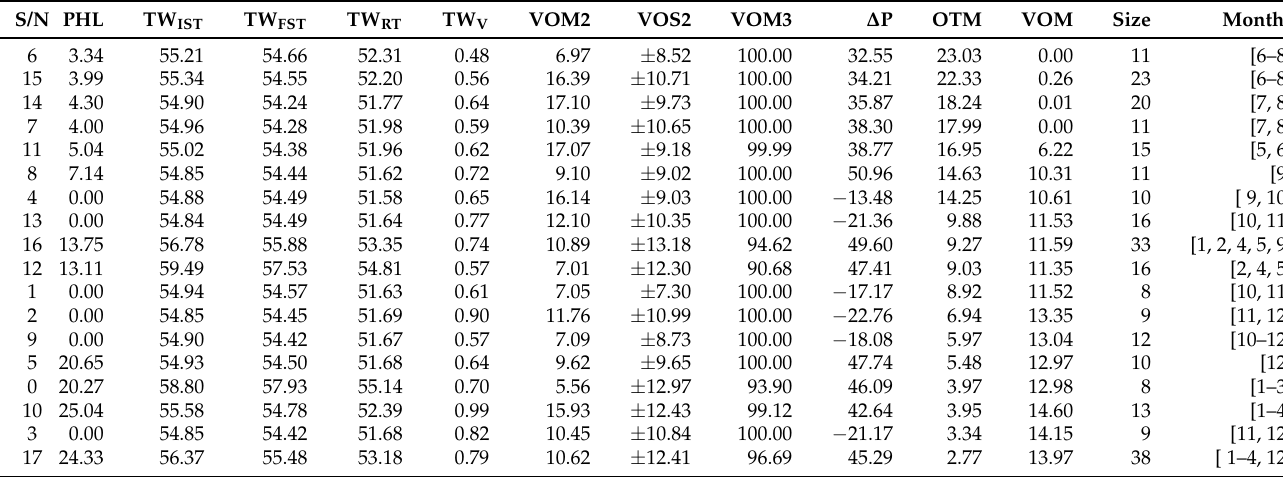
Table 15. Closed patterns from global model showing correlations between all three views after receiving chunk 3. Values are sorted based on OTM followed by TW V